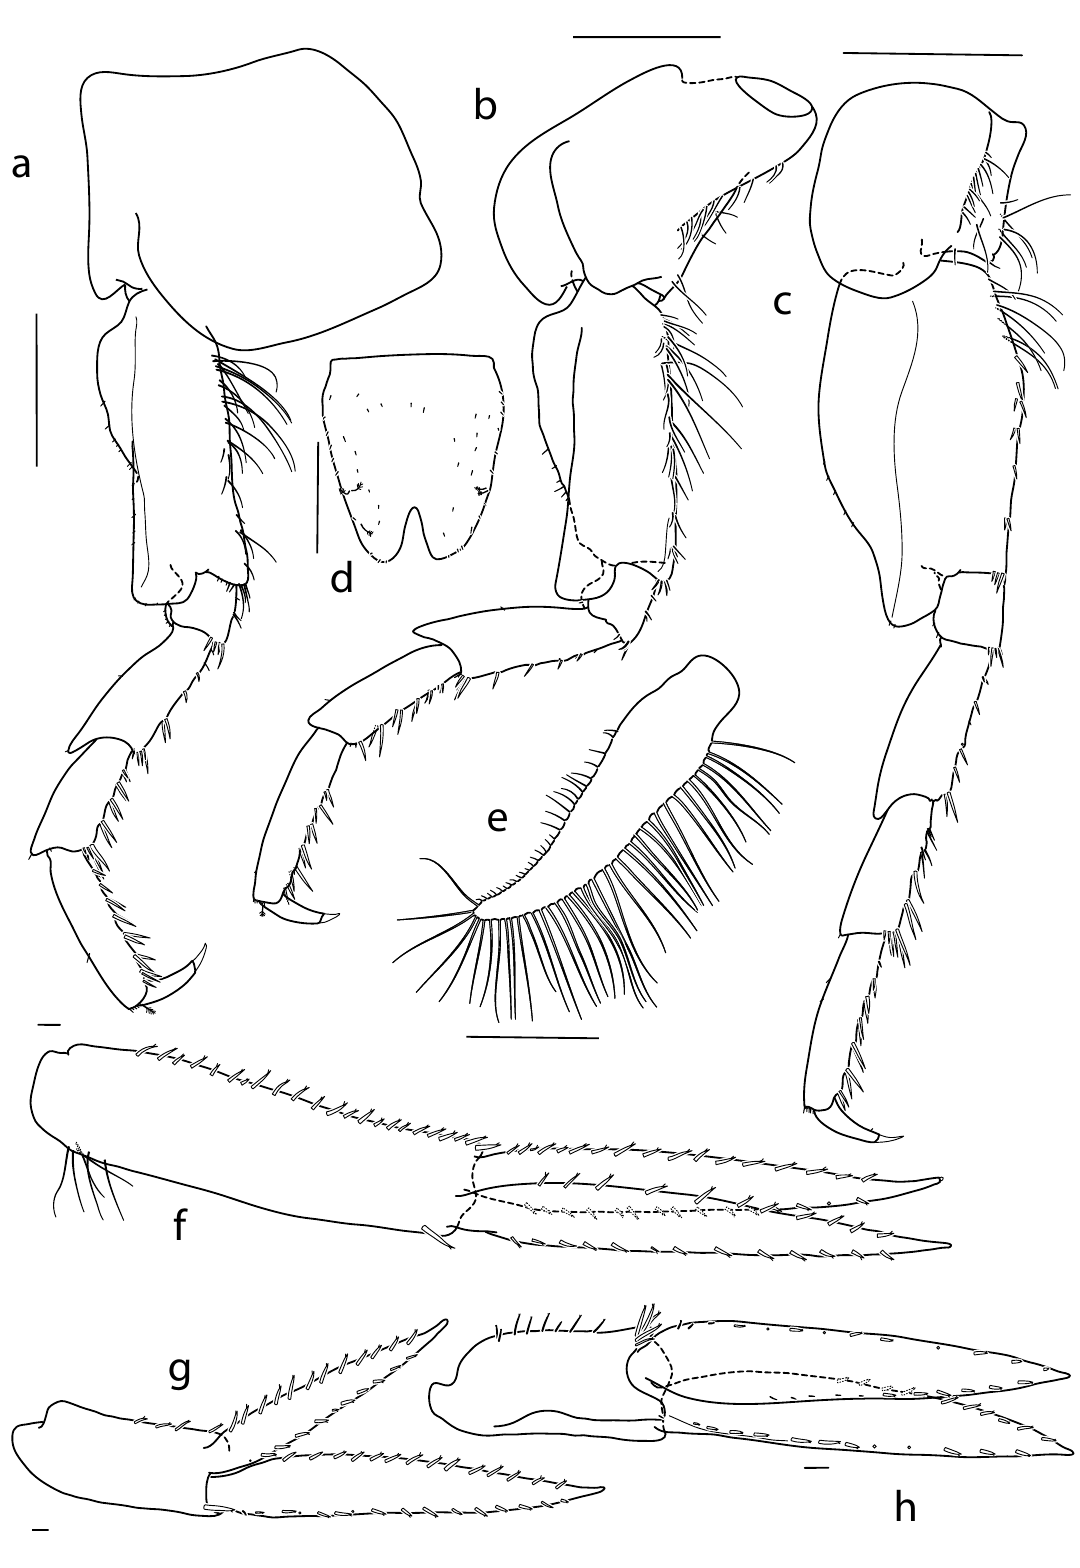
Fig. 17. Epimeria (Metepimeria) acanthurus (Schellenberg, 1931), ♀, 22 mm (ZMB 34099). a . Pereopod 5. b . Pereopod 6. c . Pereopod 7. d . Telson. e . Oostegite of pereopod 5. f . Uropod 1. g . Uropod 2. h . Uropod 3. Scale bars: a–c, e = 1 mm; d, f–h = 100